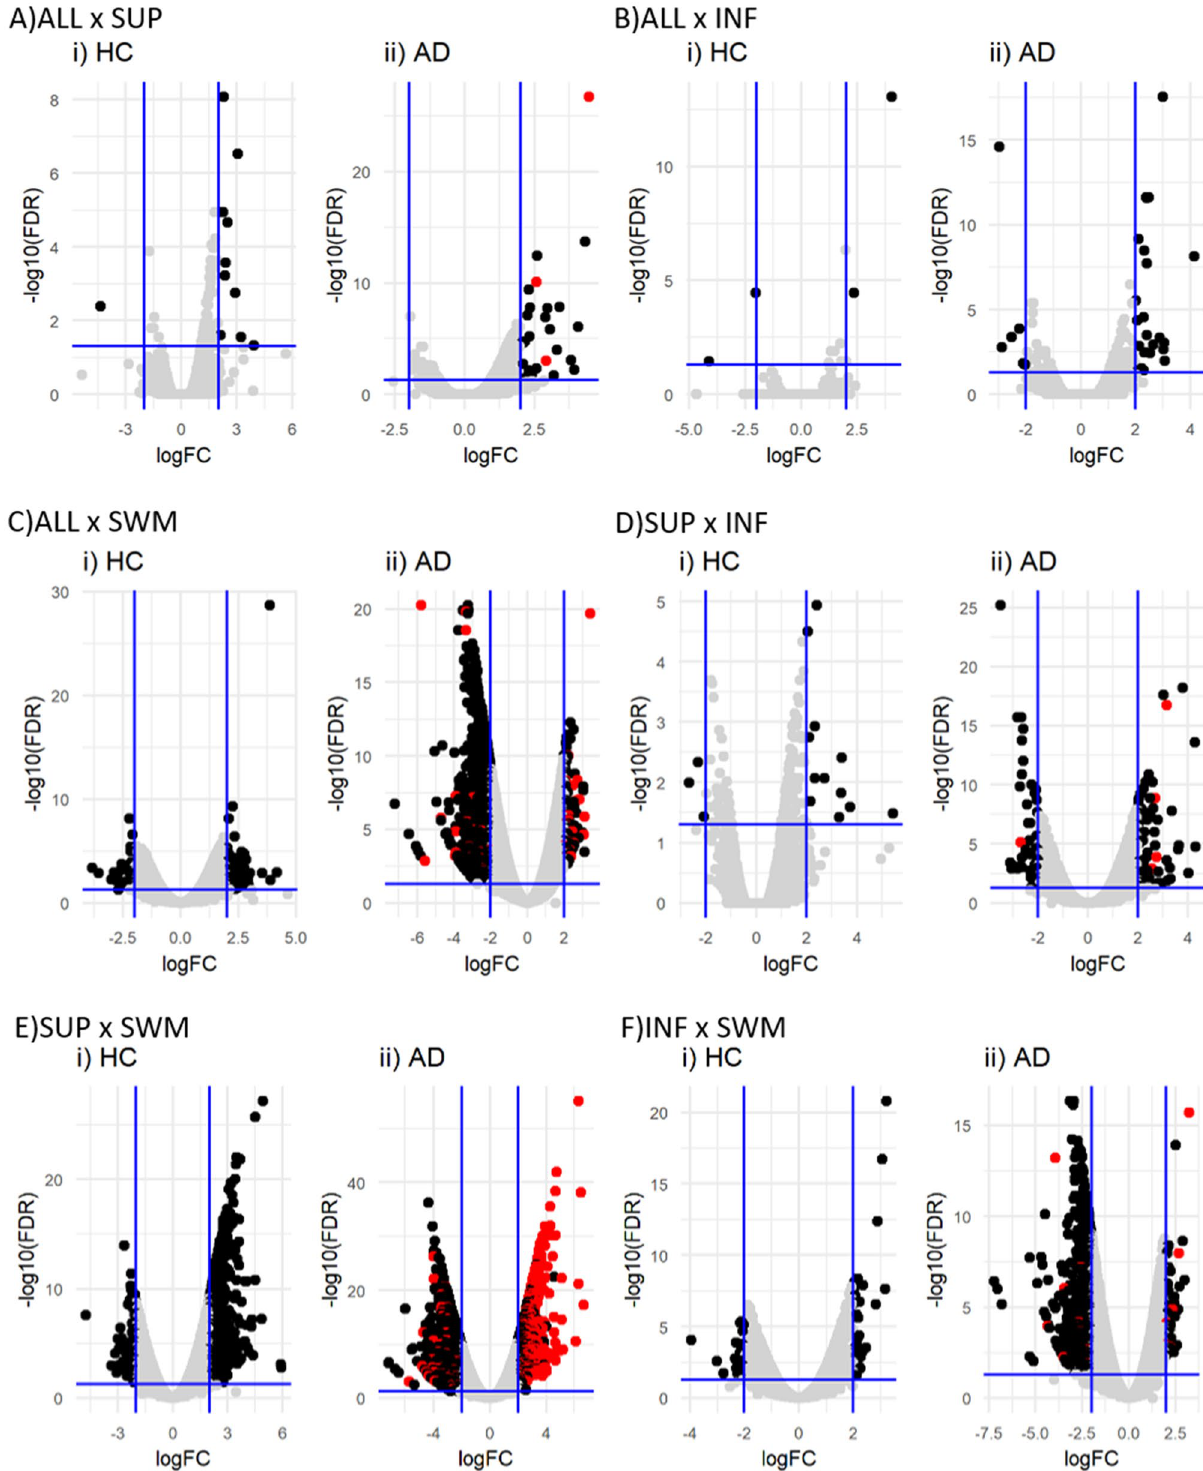
Figure 1. Differentially expressed genes amongst HC and AD layers. Volcano plot showing the DEG amongst the layers in the HC (i) and AD (ii) comparisons. All comparisons presented DEG in common (red dots in all panels), except for ALL and